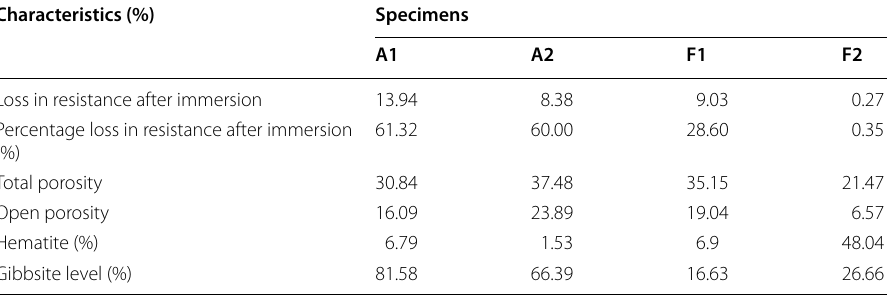
Table 6 Resistance of material lost after saturation and gibbsite content Characteristics (%)